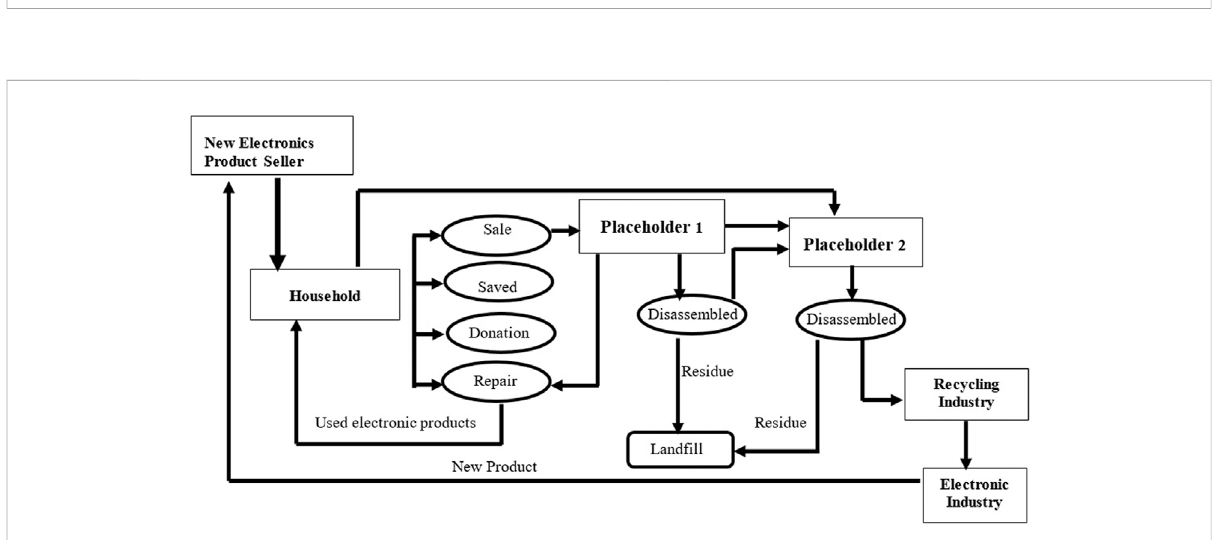
FIGURE 2 The route of the fl ow of electronic waste in DKI Jakarta, the existing